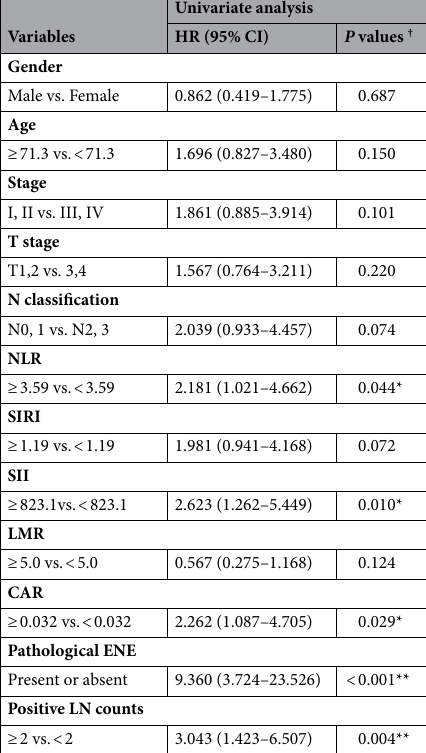
Table 3. Subgroup analysis with univariate cox regression analyses for OS in the surgery group. † By Cox